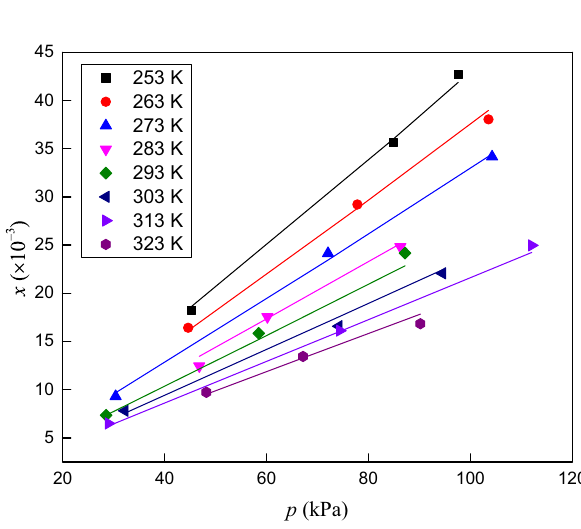
Figure 4. Solubility (mole fraction) of CO 2 in RP5 versus temperature and pressure.